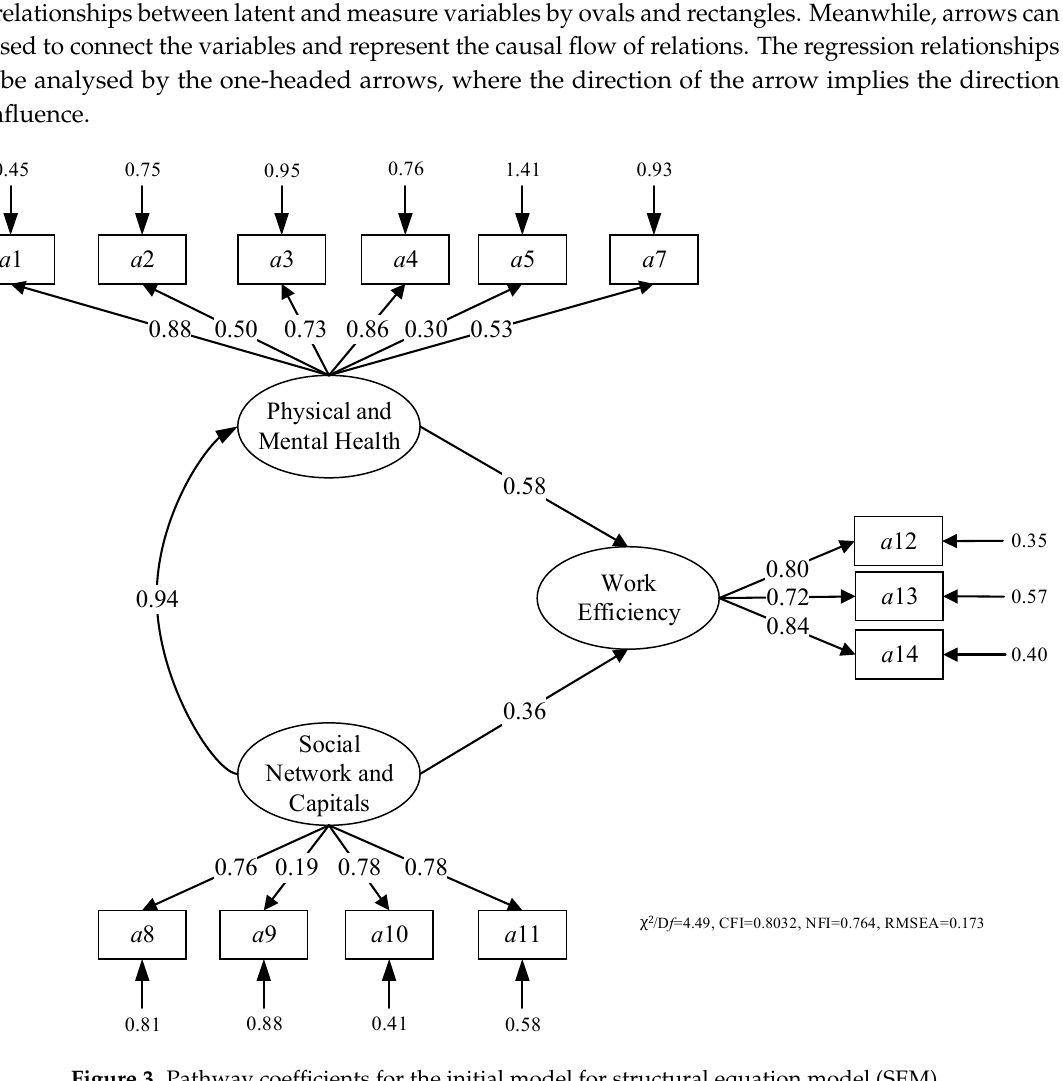
Figure 3. Pathway coefficients for the initial model for structural equation model (SEM).